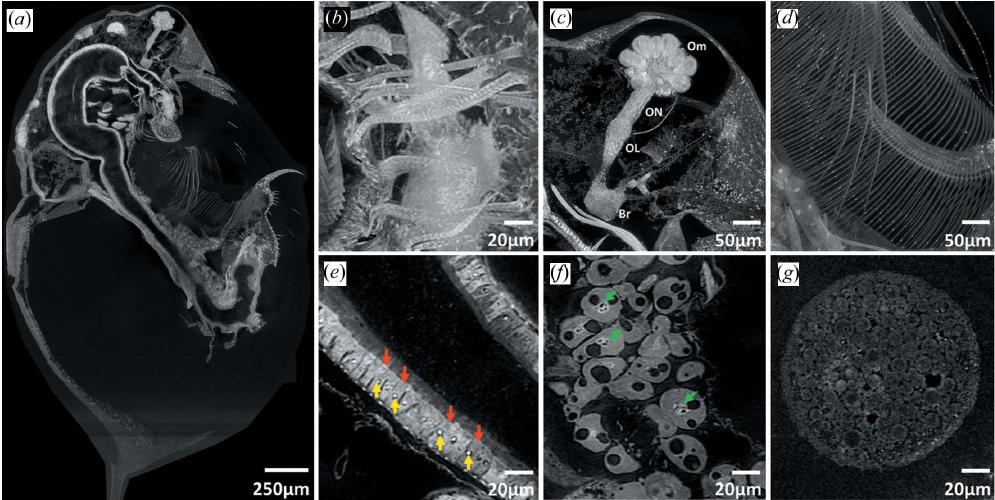
Figure 6 Adult D. magna stained with PTA showing sub-cellular resolution for different cell types and structures ( a ). Cell types and structures that can be visualized by customizing various stack thicknesses included: muscle striations (about 2 m m) on the labral muscles ( b ), ommatidia (Om), optic nerves (ON), optic lobe (OL) and brain (Br) ( c ), setae of the filter plates ( d ), nucleoli (yellow arrows, (cid:7) 2 m m diameter) in the gut epithelial cells (red arrows) ( e ), nucleoli (green arrows) in the fat cells ( f ) and yolk globules ( g ) in a developing embryo. Panels ( a ) to ( c ) were generated from maximum intensity projections (MIP) of 50 slices, panel ( d ) from an MIP of 100 slices to visualize thicker three-dimensional structures and panels ( e ) to ( g ) from an MIP of ten slices. An MIP of ten slices is equivalent to a 5 m m-thick histology